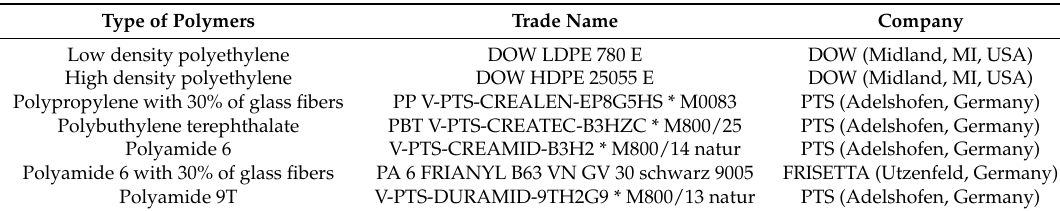
Table 1. Tested polymers.